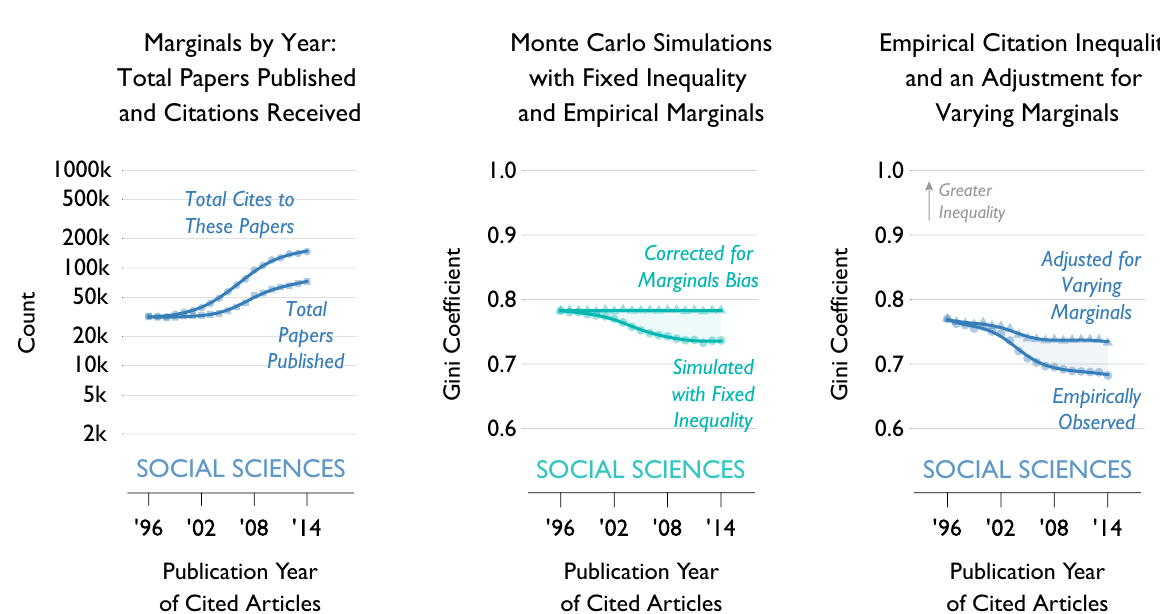
Figure 2: How the social sciences illustrate the logic of marginals bias in citation counts. Notes : The left panel shows empirical marginal counts of articles and citations within two years of publication over the years 1996–2014. The middle panel presents Monte Carlo simulations of the Gini coefficient for citations per article, and a correction for marginals bias. The right panel reports empirical measures of the Gini coefficient for the social sciences, and the adjustment for changing marginals. All curves are smoothing splines with a span of